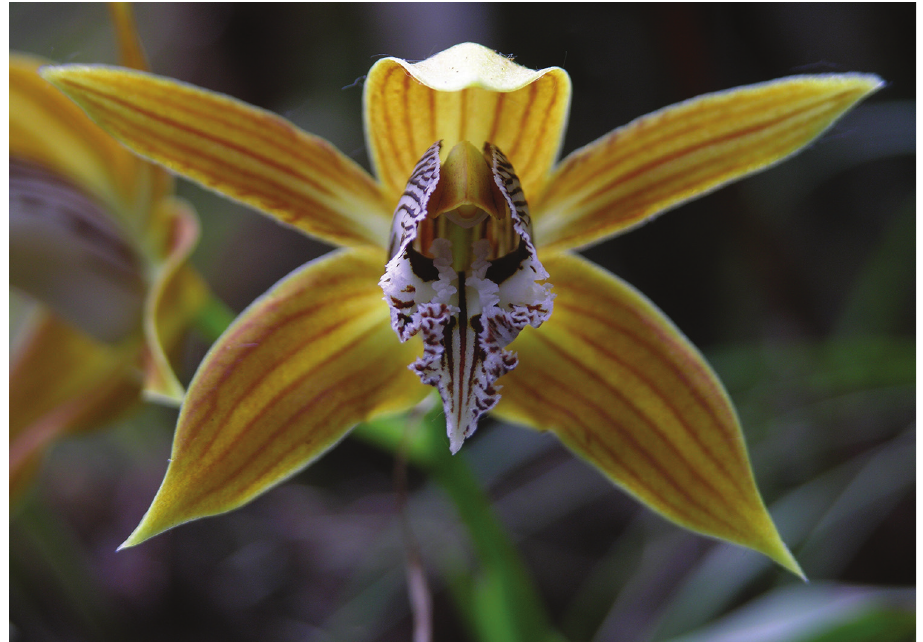
Figure 4. Close-up of flower of Coelogyne weixiensis . Photo by X.H. Jin.